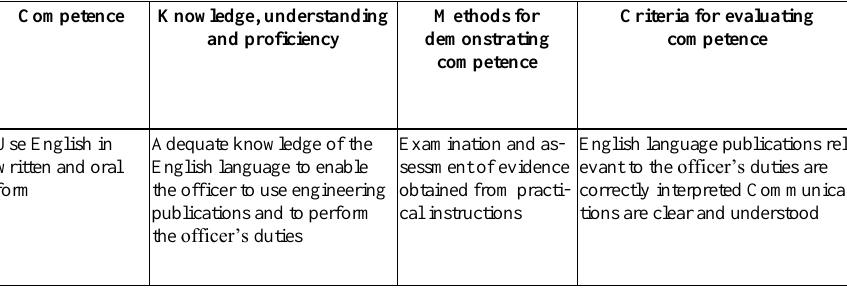
Table 1. Standards regarding the Engine Department (taken from